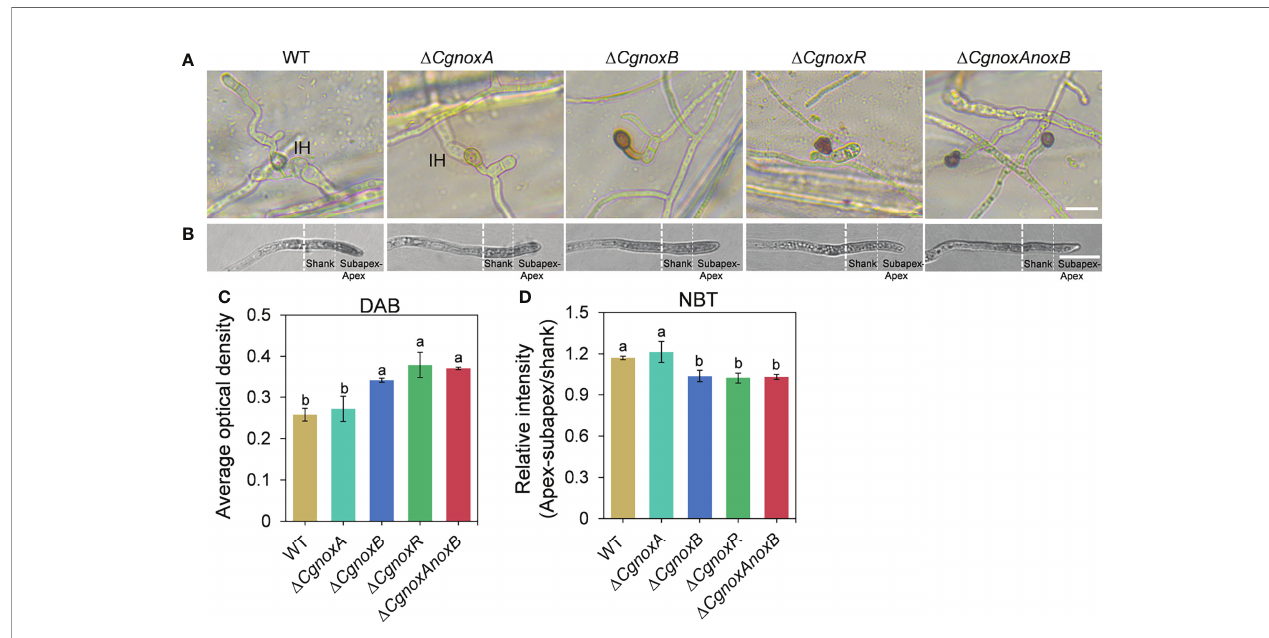
FIGURE 5 | CgNOX regulates reactive oxygen species (ROS) in C. gloeosporioides . (A) DAB staining of WT, D CgnoxA , D CgnoxB , D CgnoxR , and D CgnoxAnoxB strains after inoculation on onion epidermis for 12 h. Scale bar = 10 m m. (B) Germinated conidia of WT, D CgnoxA , D CgnoxB , D CgnoxR , and D CgnoxAnoxB strains were stained with nitro blue tetrazolium chloride (NBT) and viewed under light microscopy. White dotted lines indicate the regions for the measurement. Scale bar = 10 m m. (C) The deposition of dark brown polymers in appressorium was analyzed using ImageJ software. Bar chart showing AOD (average optical density) of each strain. Bars represent standard deviations (SD). Columns with different letters indicate signi fi cant difference (p < 0.05). At least 60 appressoria from each strain were analyzed. (D) The AOD of formazan precipitate of apex – subapex and shank in the hyphal tips were quanti fi ed through ImageJ software. Bar chart showing the ratio of AOD of apex – subapex to shank. Bars represent standard deviations (SD). Columns with different letters indicate signi fi cant difference (p < 0.05). At least 10 hyphae from each strain were